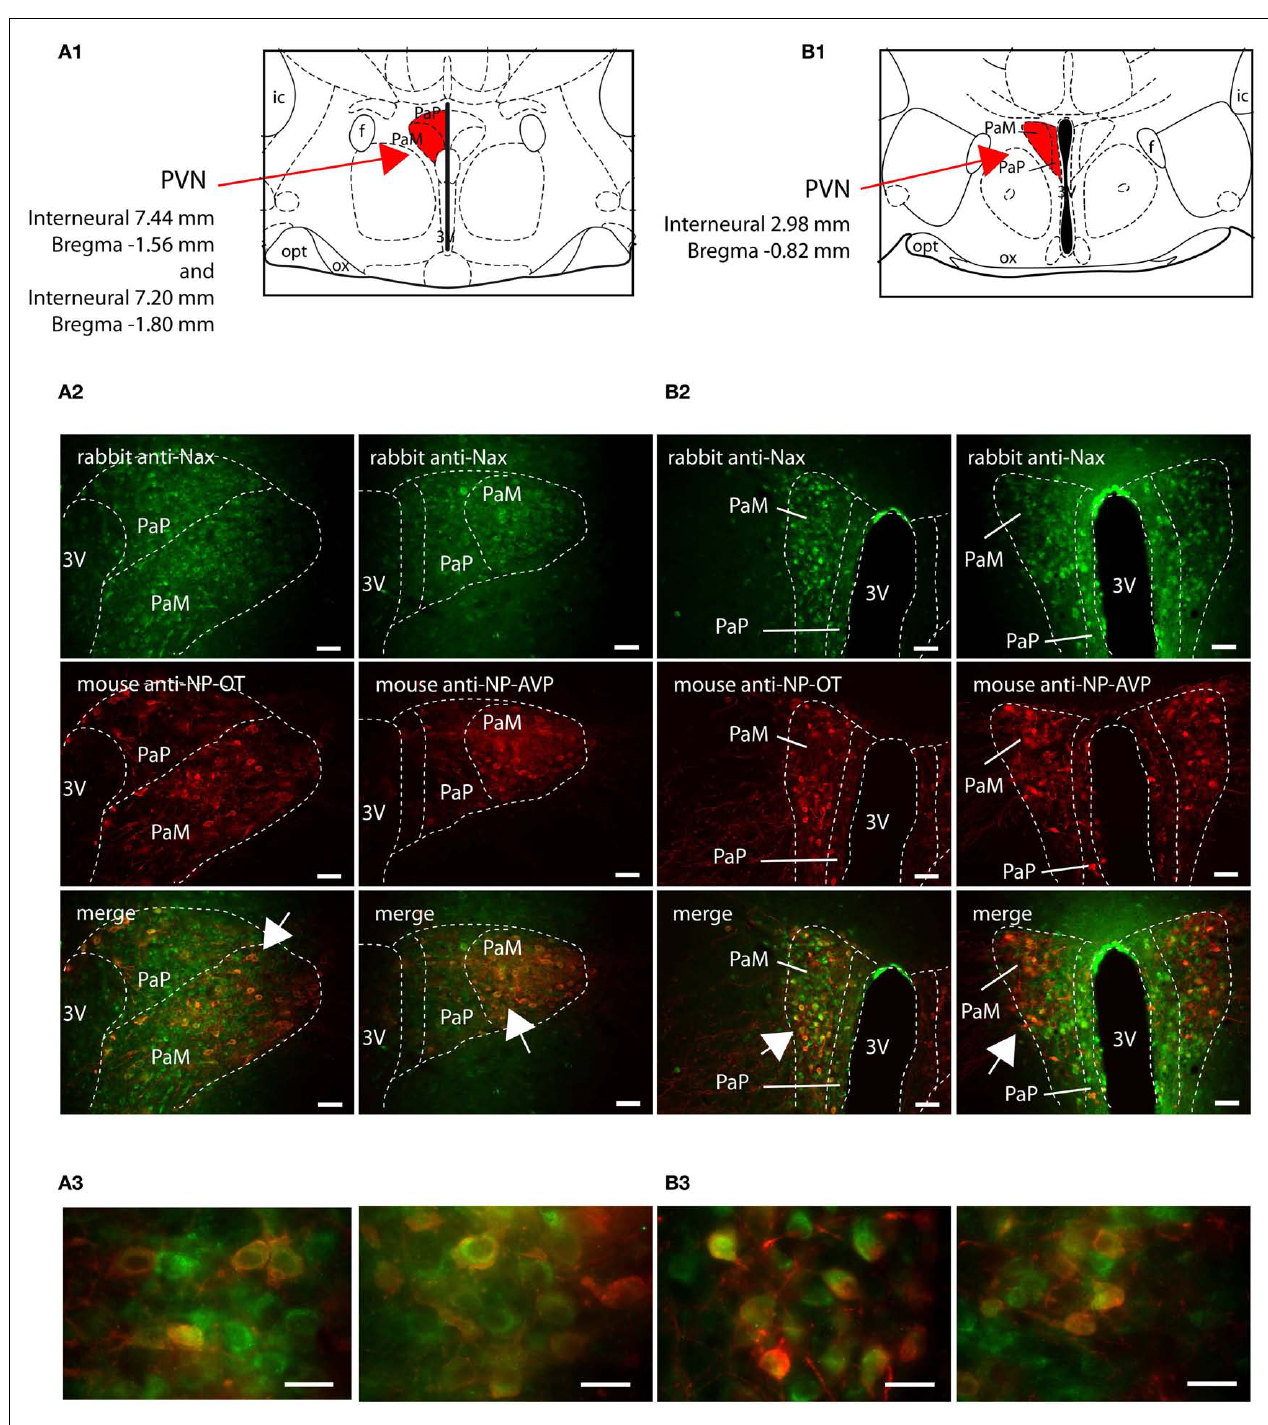
cells expressing Na X was identified with the anti-oxytocin neurophysin and the anti-vasopressin neurophysin fluorescent immunostaining (red); scale bars: 50 µ m.The arrow head points the top-right, the bottom-right, and the bottom-left corner of the inset, which represents a high magnification zone of the PVN in the rat (A3) and in the mouse (B3) ; scale bar: 20 µ m. Not that NaX immunostaining was present in both vasopressinergic and oxytocinergic magnocellular cells in the rat and